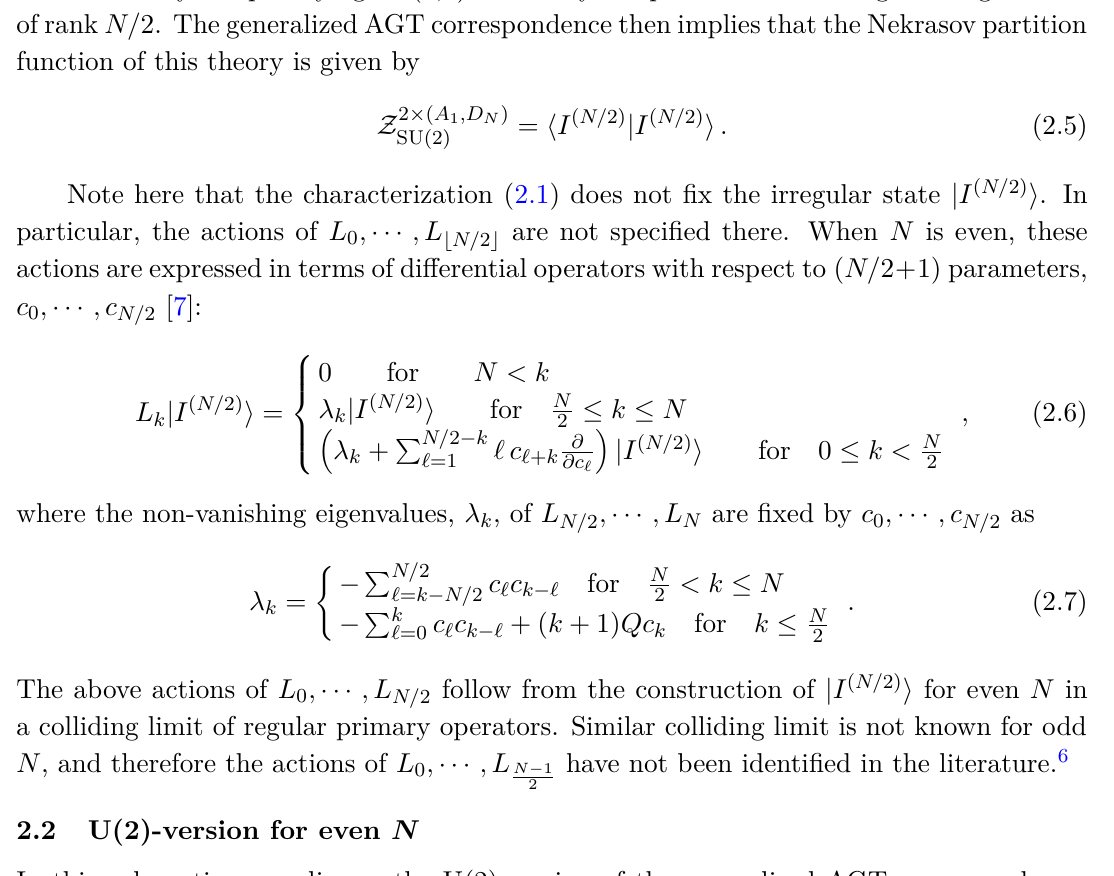
Figure 3 . SU (2) gauge theory coupled to two ( A 1 , D N )